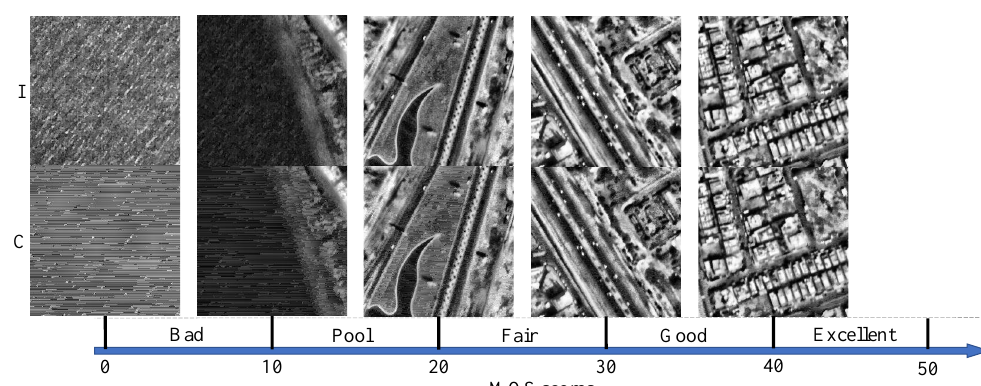
Figure 6. MOS visual examples. The visual example is presented as a Likert. The possible similarity range is labeled from low to high with five adjectives: Bad, Poor, Fair, Good, and Excellent; and five exemplar image pairs are shown above each Likert